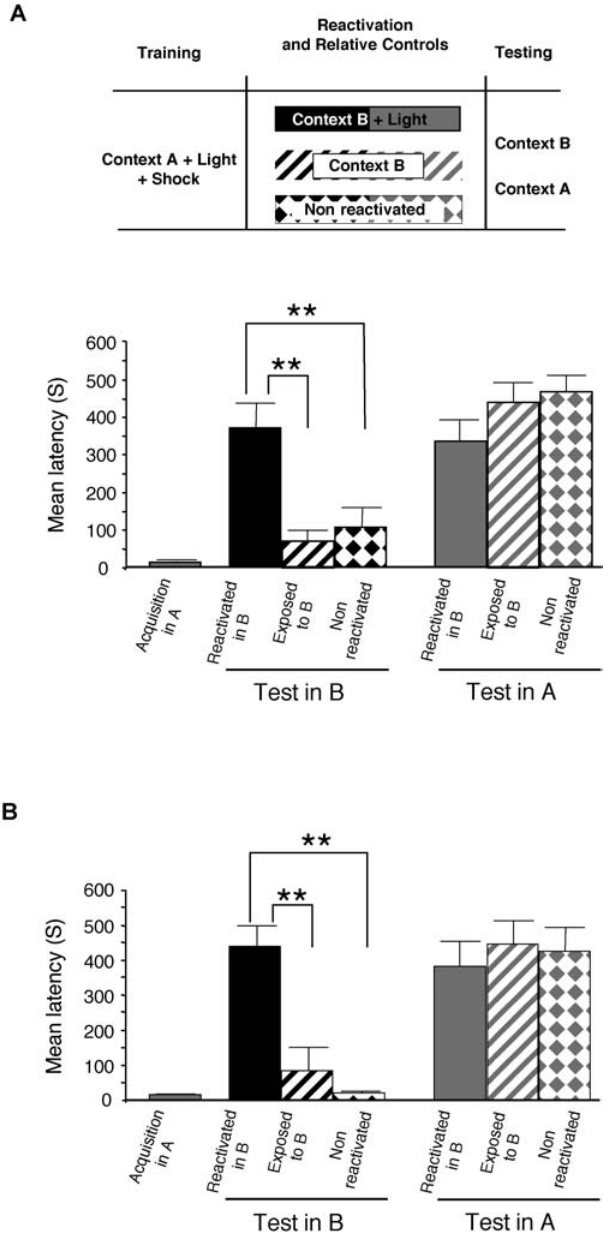
Figure 1. Associations Are Formed between New Information and a Reactivated Memory Both the original and the new memory are long-lasting. Latency to enter the shock chamber was taken as a measure of memory acquisition and retention. (A) Rats trained in context A ( n ¼ 72) that received memory recall by visual CS in context B developed a strong fear memory for context B ( n ¼ 12), while both control groups (rats exposed to context B without reactivation and non-reactivated; n ¼ 12 per group) had no memory for context B (** ¼ p , 0.01). Rats that underwent the same training and reactivation protocol but were tested in context A ( n ¼ 12) showed retention levels similar to those of both control groups ( n ¼ 12 per group). Latencies to enter either context A or B were similar, suggesting that the new memory is as strong as the old one. (B) All groups ( n ¼ 8 per group) were re-tested 1 wk after the first test. Similar results were obtained. DOI: